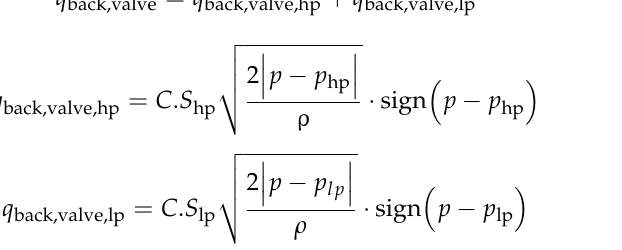
Figure 5. Schematic diagram of leakage flow of slipper/swash plate interface.